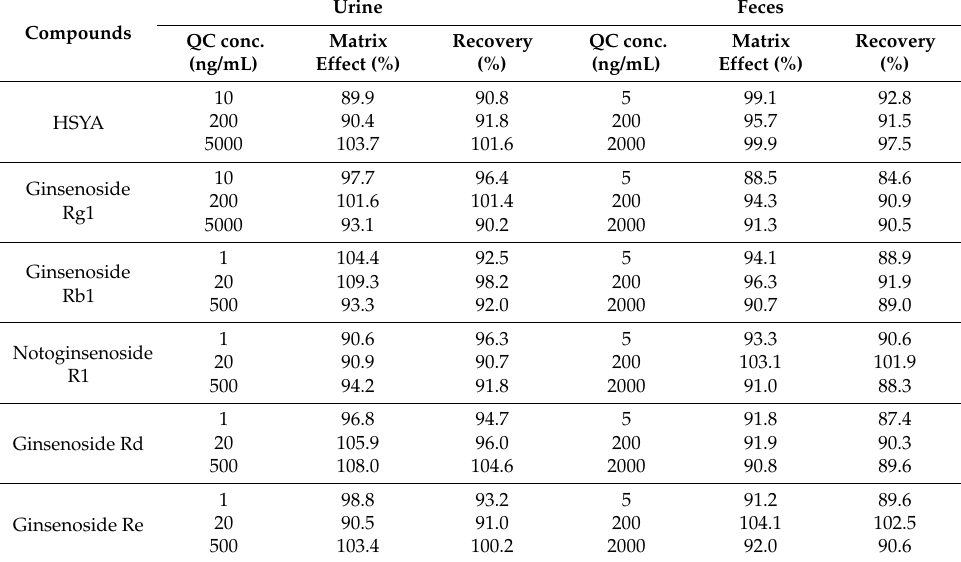
Table 5. Recovery and matrix effect of six compounds in urine and feces ( n =